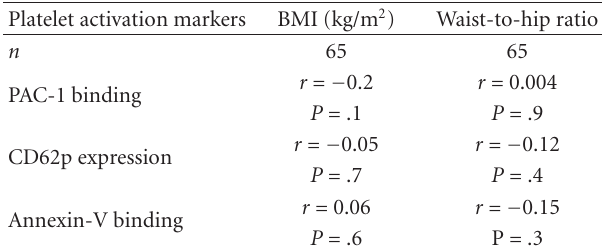
Table 5: Correlations between platelet activation markers, body mass index, and waist-to-hip ratios for subjects in the platelet ac- tivation